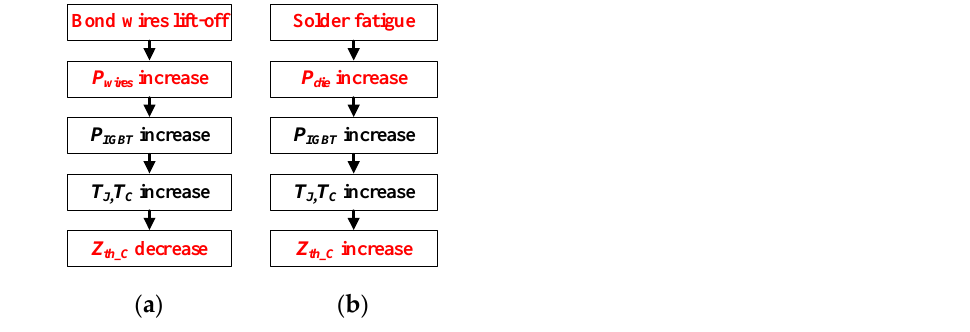
Figure 20. Effect of failure mechanism on thermal resistance measurement ( a ) bond wires lift-off ( b ) solder fatigue.